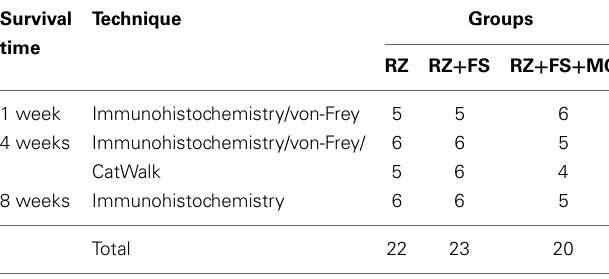
Table 1 | Number of animals allocated per group and